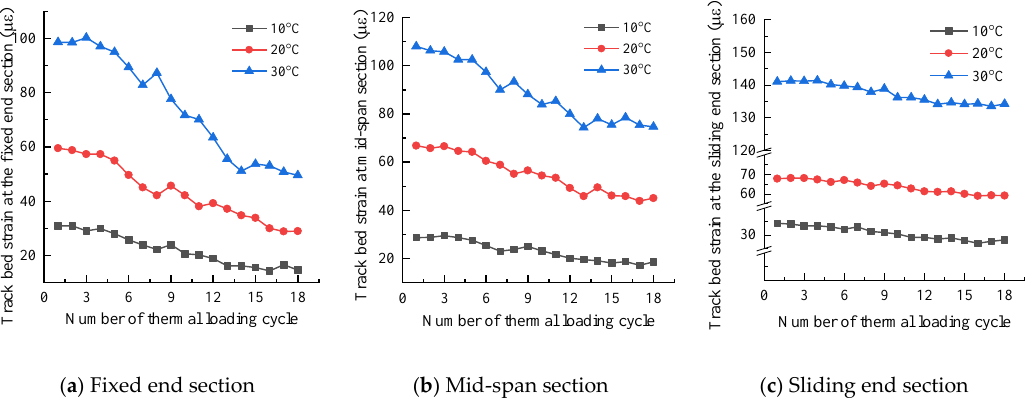
Figure 16. Variation of the track bed strain with the thermal loading cycles.